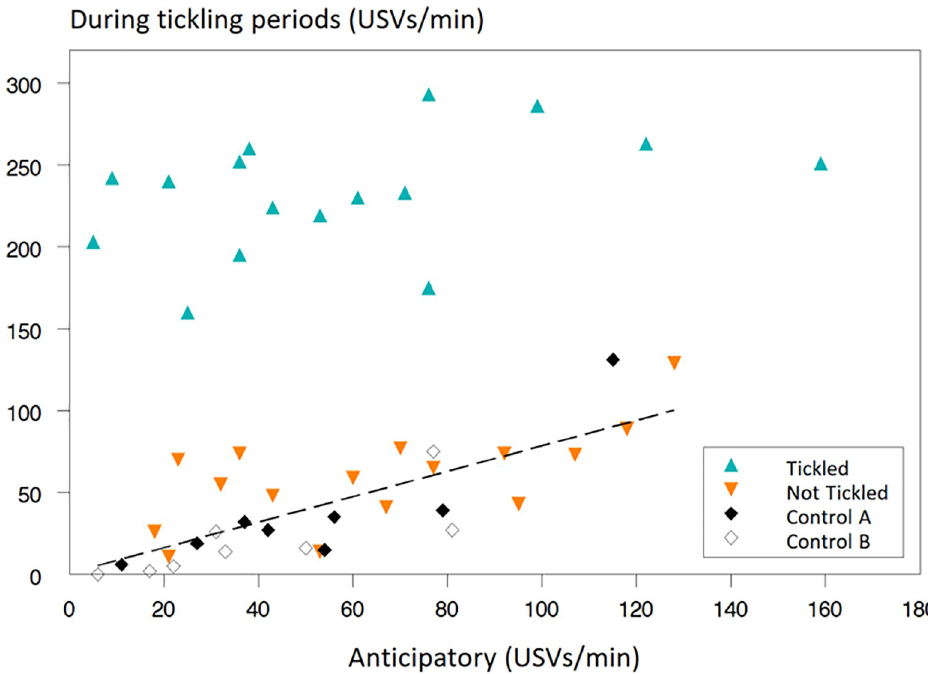
Fig 3. Data plot of 50 kHz ultrasonic vocalisations (USVs) per minute during the 5 th session in the periods when tickling occurred for the Tickled rats plotted against the USVs per minute during the 60-s period (anticipatory) prior to tickling. Each data point is an individual rat, with Control rats plotted for both Odours A and B. The regression equation, where data from Tickled rats have been excluded, is Y = 1 + 0.78X (R 2 = 58%; P < 0.001).